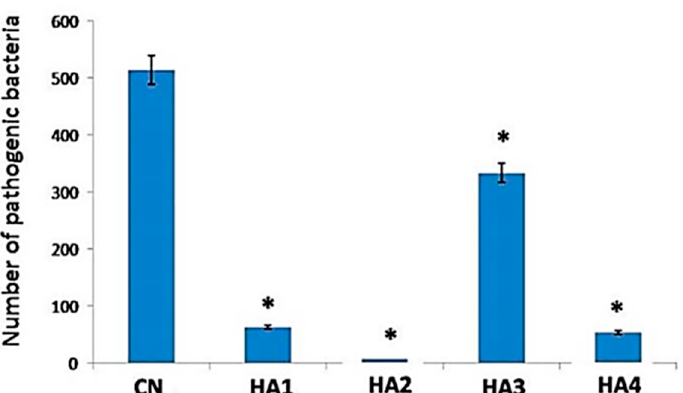
Figure 3. Total count of pathogenic bacteria grown on the full thickness wounded skin from older untreated (control, CN) and treated rats. * Indicated the significance in comparison with the control. Reprinted from [29]. Copyright 2016, with permission from